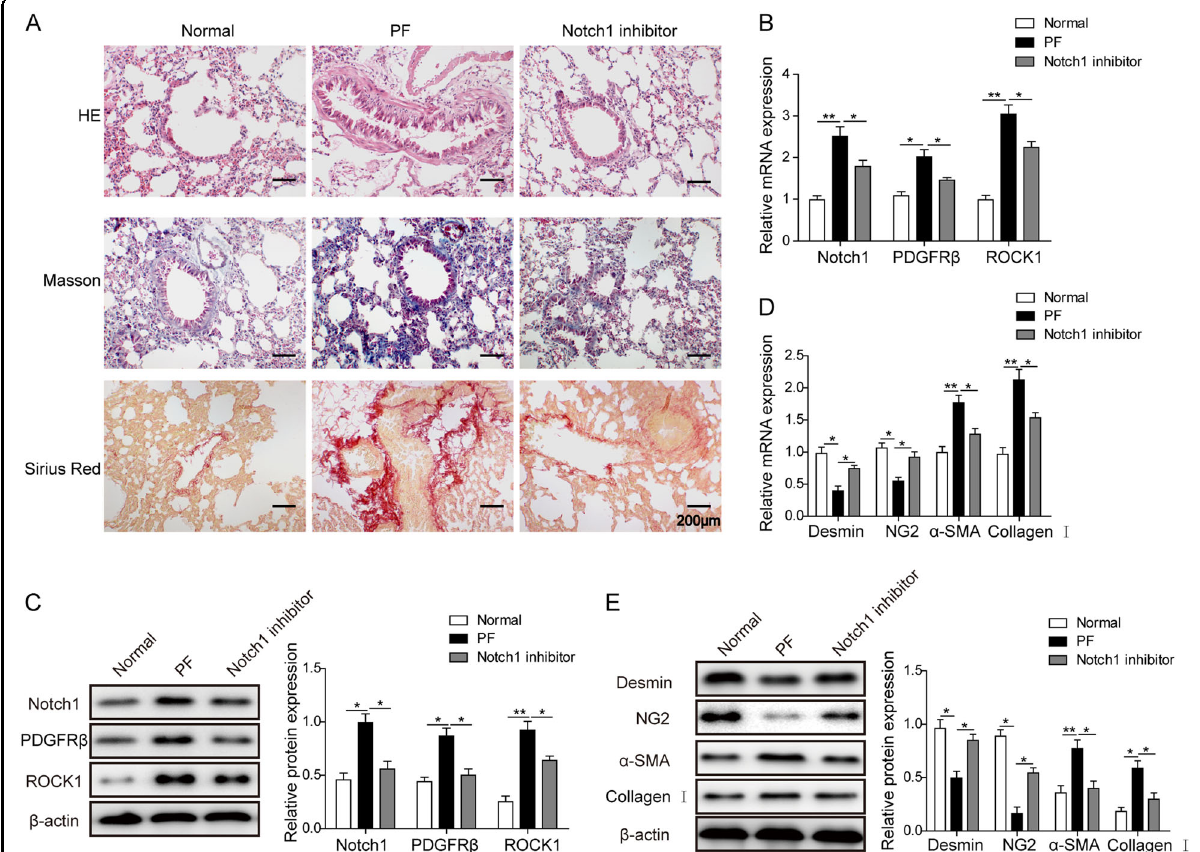
Fig. 5 Notch1 inhibitor alleviated mouse pulmonary fi brosis in vivo. a Tissue staining of mouse lungs by the HE, Masson and Sirius Red methods. b Relative mRNA expression of the Notch1, PDGFR β , and ROCK1 genes in the normal, PF and Notch1 inhibitor groups. c Western blot for the expression of proteins in the Notch1 signaling pathway. d Relative mRNA for desmin, NG2, α -SMA, and collagen I genes in the three groups. e Western blot analysis showing the protein levels of desmin, NG2, α -SMA, and collagen I in the normal, PF and Notch1 inhibitor tissues. The means ± SD in the graph present the relative levels from three replicates. * p <